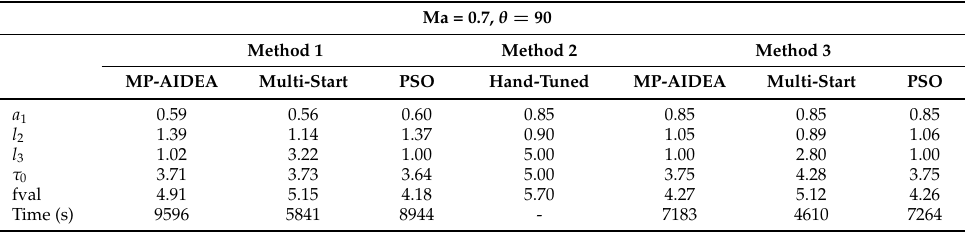
Table 3. Ma = 0.7, θ = 90: Comparison of parameters found from the optimization methods.